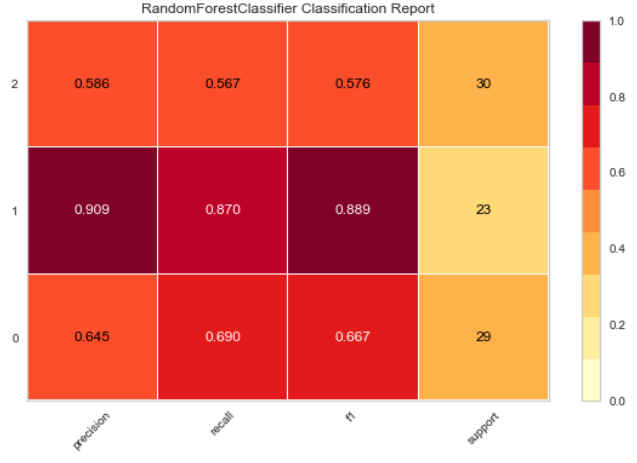
Fig. 15. Classification report for RF.